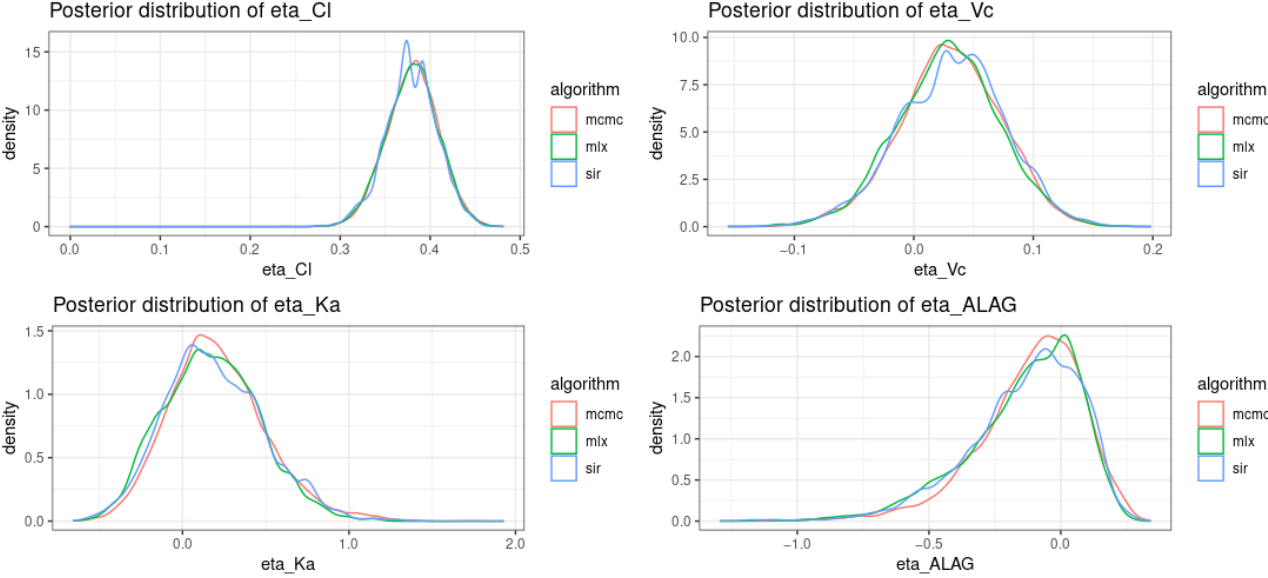
Figure 4. Density plots of the posterior distributions of η i for subject #1 with model #003.mcmc, the MCMC algorithm implemented in posologyr; mlx, the MCMC algorithm of Monolix; sir, the SIR algorithm of posologyr; Cl, clearance; Ka, absorption rate; Vc, central volume of distribution; ALAG, lag-time.